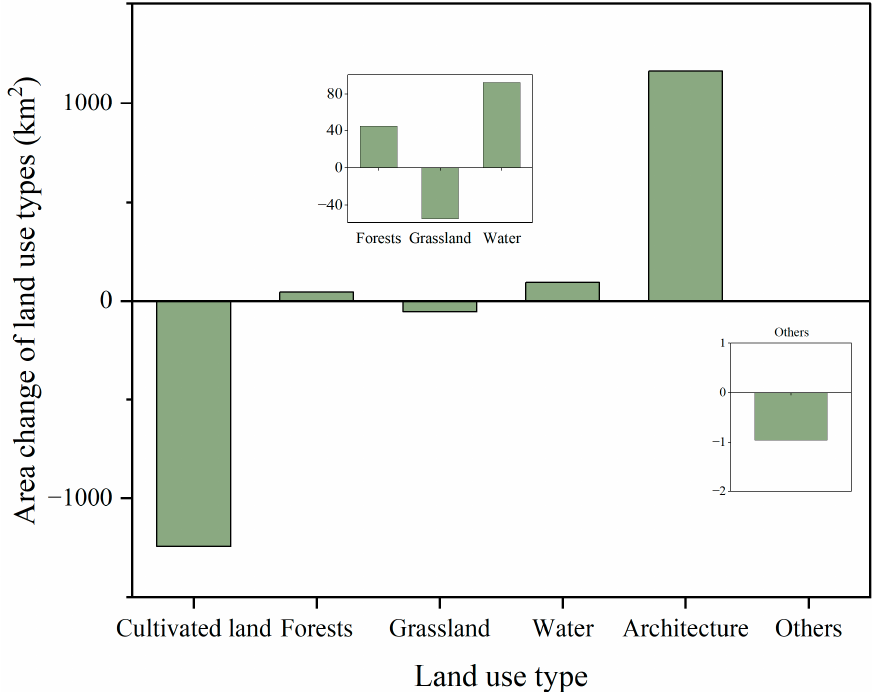
Figure 13. Area changes in land use types in the ecological protection scenario from 2020 to 2035.